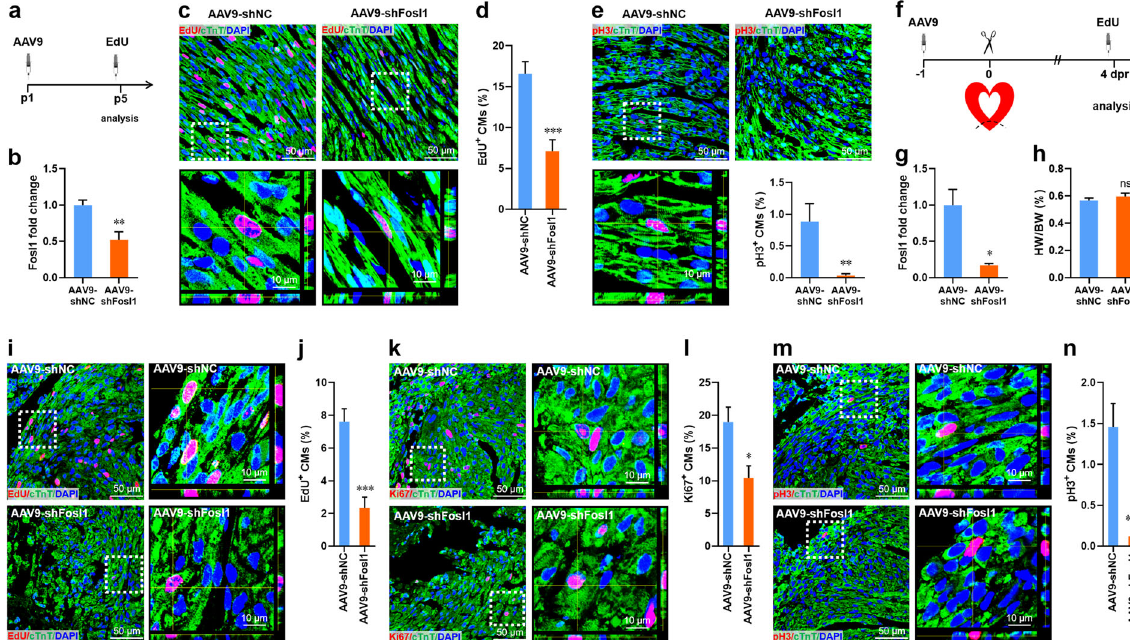
Fig. 9 Fosl1 silencing inhibits cardiomyocyte proliferation during heart regeneration in neonatal mouse. a Schematic of AAV9-shFosl1 virus injection to silence Fosl1 in the quiescent neonatal heart. b qPCR validation of Fosl1 knockdown in the neonatal heart after AAV9-shFosl1 injection ( n = 5 hearts). c , d Representative images ( c ) and quanti fi cation ( d ) of EdU + cardiomyocytes in ventricle apex ( n = 8 hearts). Lower panels of c are the magni fi ed confocal images of EdU + cardiomyocytes. e Representative images and quanti fi cation of pH3 + cardiomyocytes in the ventricle apex ( n = 8 hearts). Lower panels are the magni fi ed images of pH3 + cardiomyocytes. f Schematic of AAV9-shFosl1 virus injection to silence Fosl1 in the injured heart at 4 dpr. g qPCR validation of Fosl1 knockdown in the injured heart ( n = 3 hearts). h Quanti fi cation of heart weight (HW) to body weight (BW) ratio ( n = 3 hearts). i , j Representative images ( i ) and quanti fi cation ( j ) of EdU + cardiomyocytes in the ventricle apex ( n = 8 and 5 hearts). Right panels of i are the magni fi ed images of EdU + cardiomyocytes. k , l Representative images ( k ) and quanti fi cation ( l ) of Ki67 + cardiomyocytes in the ventricle apex ( n = 8 and 5 hearts). Right panels of k are the magni fi ed images of Ki67 + cardiomyocytes. m , n Representative images ( m ) and quanti fi cation ( n ) of pH3 + cardiomyocytes in the ventricle apex ( n = 8 and 5 hearts). Right panels of m are the magni fi ed images of pH3 + cardiomyocytes. All data are presented as mean ± SEM. * p < 0.05, ** p < 0.01, *** p < 0.001 versus shNC (Student ’ s t